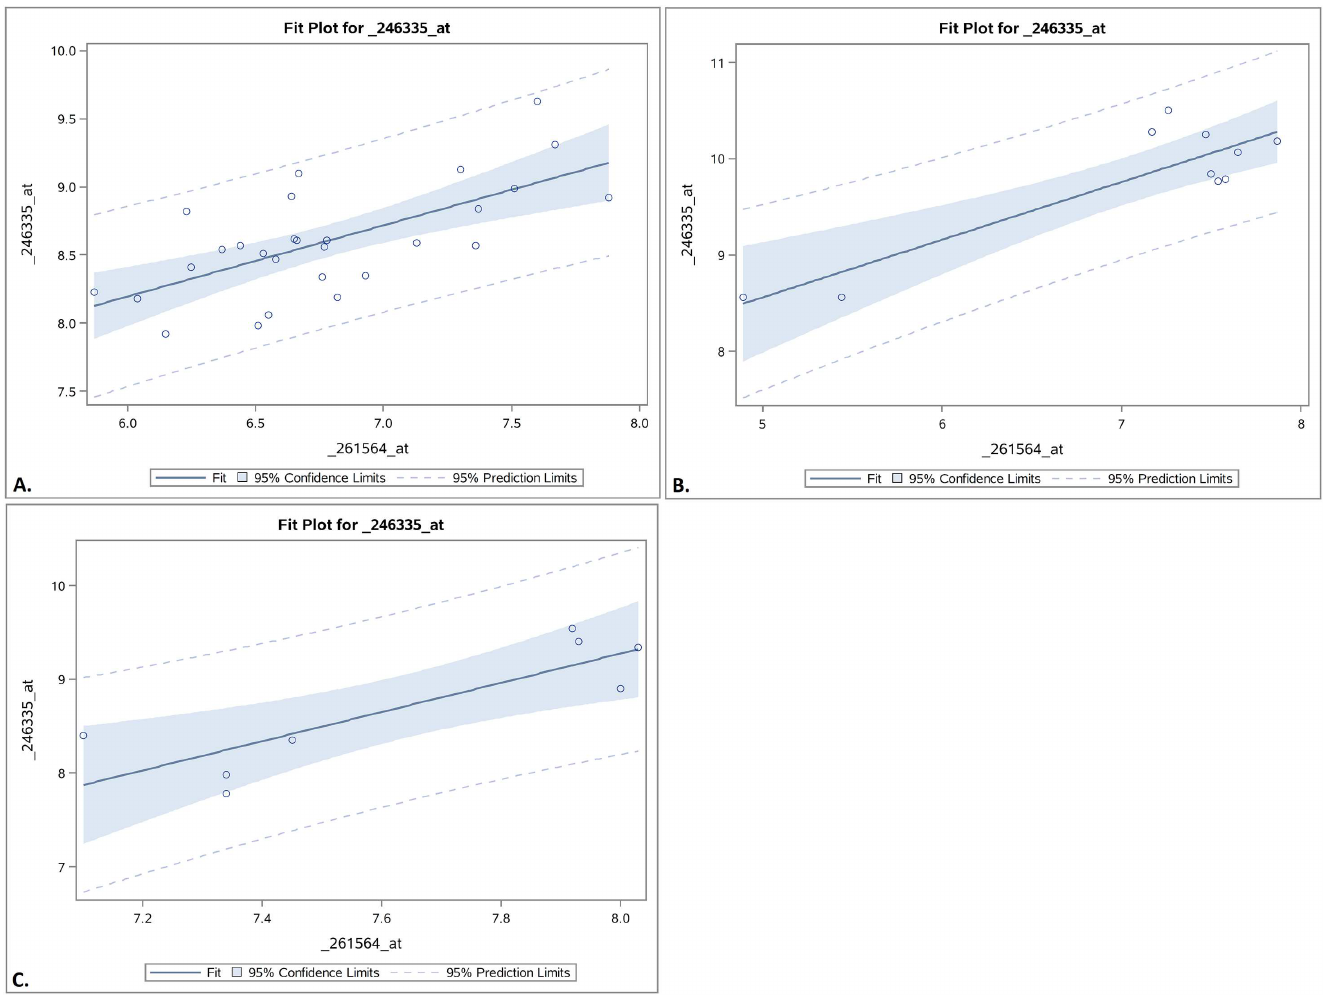
Fig 2. GLM-basedfit plotof ATAF1 vs. PAO. The fit plot shows the values of ATAF1 (x-axis)and PAO (y-axis)in each observation, visually showing a positive correlation. The modelfromthe GLM is overlaid onto the existing data of the GSE55907, GSE5727,and GSE72050microarray datasetsand the existing data fit withinthe 95% predictionlimits of the model in normalvs. pre-freezing treatment( A ),pre-senescence vs. duringsenescence ( B ),and drought vs. well-waterconditions ( C ),respectively.